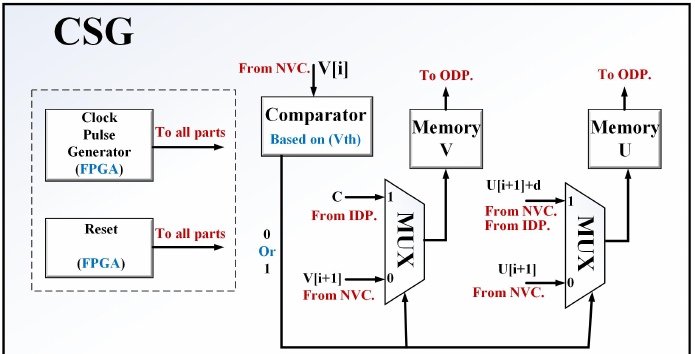
Figure 7. Control unit for the CLOCK and Reset pulses and also neuron voltage